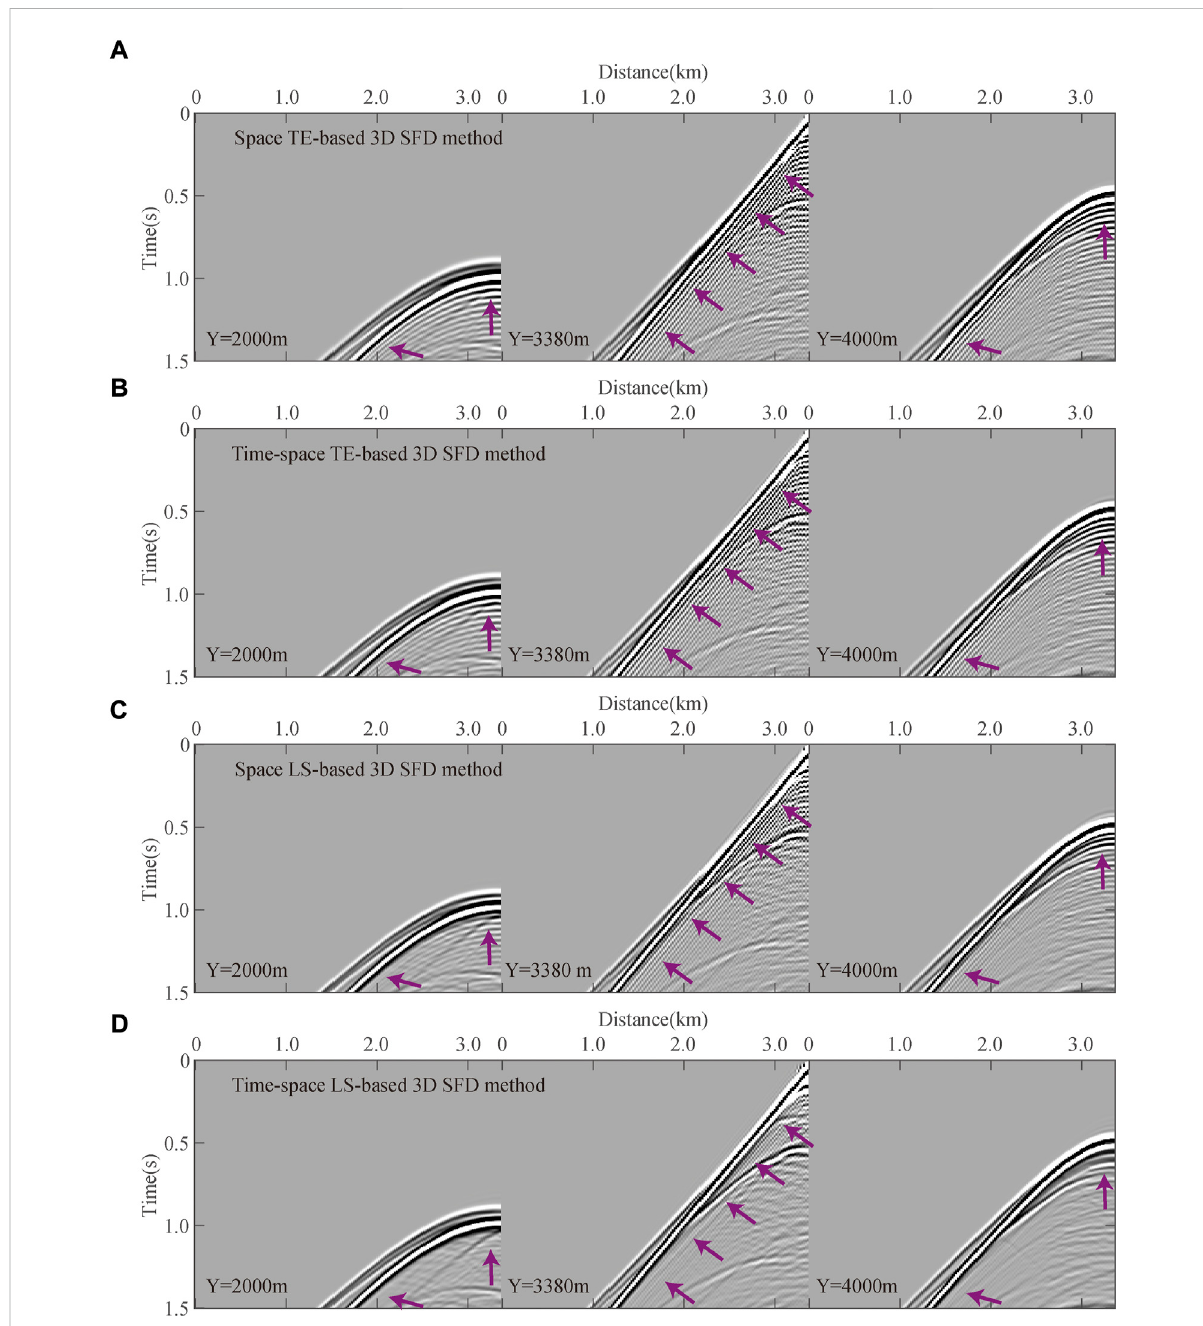
FIGURE 12 Local 2D slices of the 3D seismic records generated by different 3D SFD methods ( M (cid:2) 5) along x direction for the 3D SEG/EAGE salt model. These subgraphs (A – D) indicate different positions and different 3D SFD methods listed in